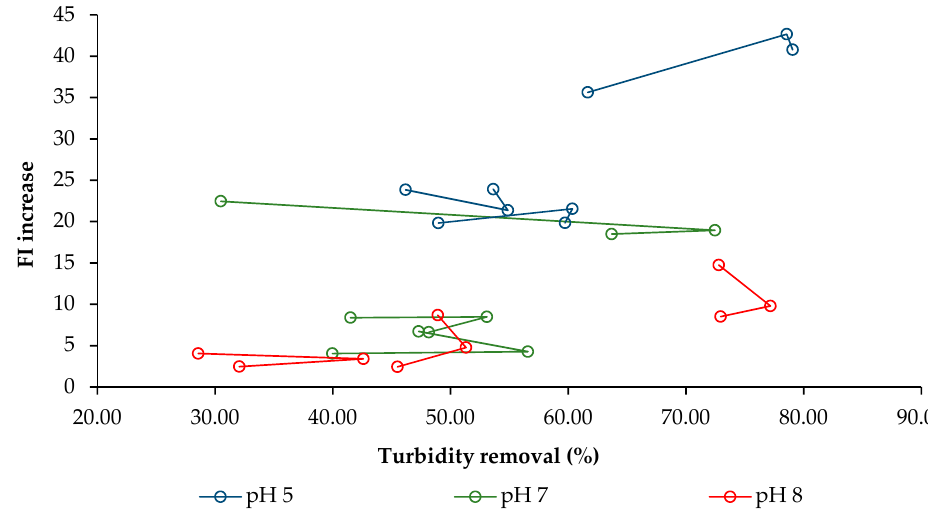
Figure 6. FI increase x turbidity removal percentage for Type I and II water samples.